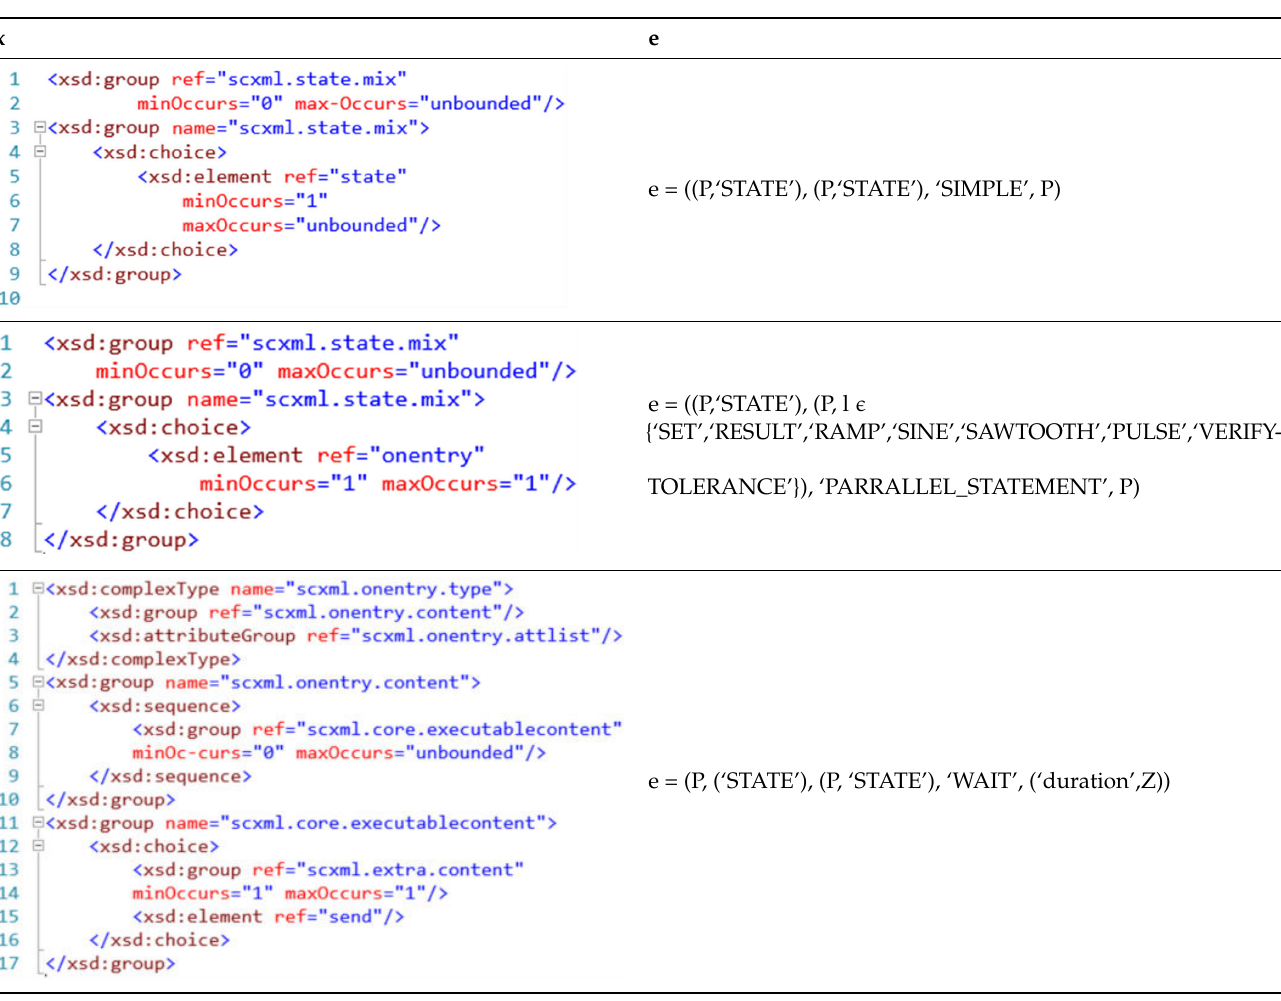
Table 4. Mapping of SCXML nodes to graph